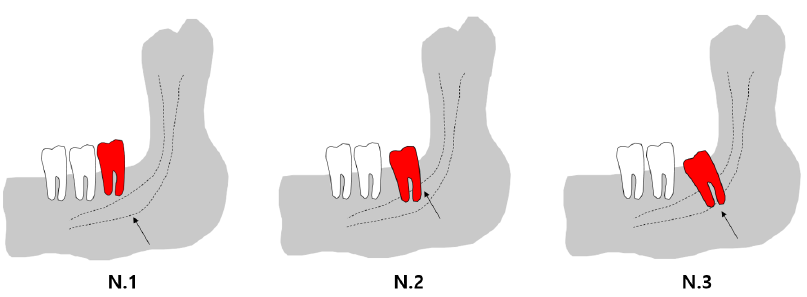
Figure 5. Relationship between the inferior alveolar nerve and the mandibular third